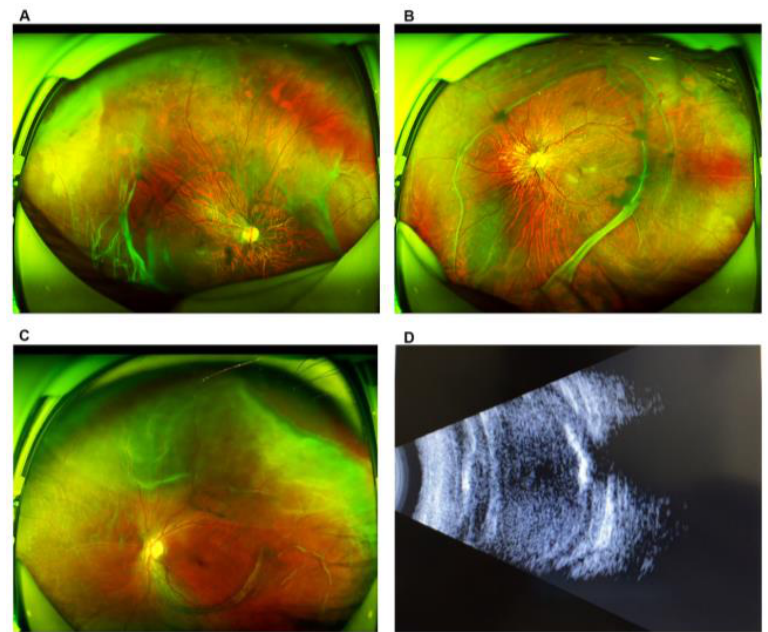
Figure 1. Scanning laser ophthalmoscopy (SLO) and B-scans of patients with Stickler syndrome. ( A ) and ( B ) are from the same proband. ( A ) Vitreous degeneration, multiple retinal holes, and retinal detachment in the right eye. ( B ) Vitreous degeneration and retinal holes in the left eye. ( C , D ) are from the same proband. ( C ) Retinal detachment of the left eye. ( D ) B-scan showing retinal detachment, vitreous opacity, and ophthalmatrophia. Table 1. Demographic and clinical data for this study.